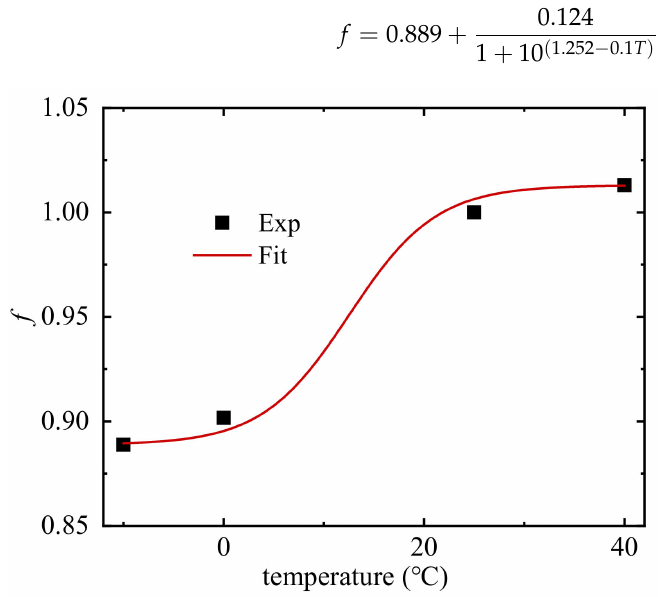
Figure 9. The fitted curve of scaling factor f versus